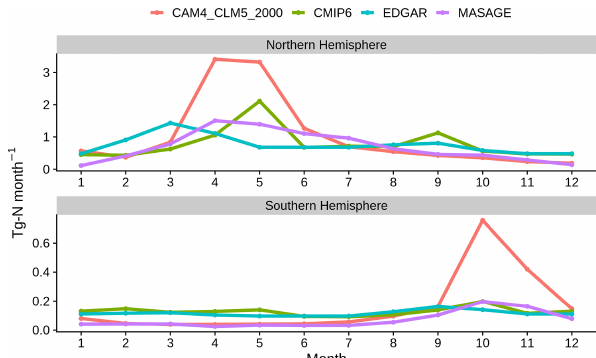
Figure 3. Monthly NH 3 emission associated with synthetic fertil- izer use in the Northern Hemisphere and Southern Hemisphere es- timated by CLM5, CMIP6, EDGAR, and